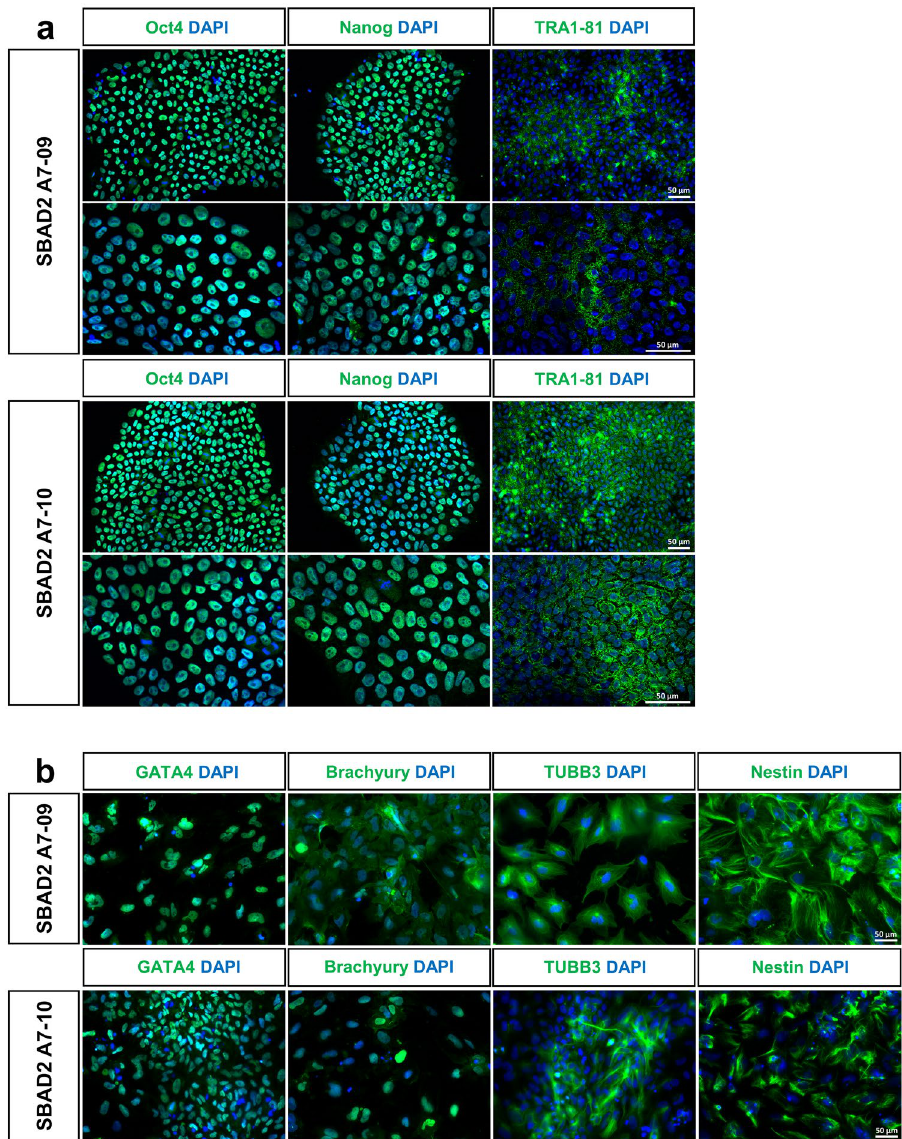
Figure 5. Pluripotency tests. ( a ) Representative immunofluorescent micrographs of undifferentiated SBAD2- iRFP720 reporter hiPSCs, that were positively stained for stem cell markers OCT4, NANOG and TRA1- 81 (in green), nuclei were labeled with DAPI (in blue). ( b ) SBAD2-iRFP720 hiPSCs were spontaneously differentiated and analyzed by immunocytochemistry. Multilineage differentiation potential was confirmed by immunostaining for endodermal (GATA4), mesodermal (BRACHYURY) and ectodermal (TUBB3, NESTIN) germ layers (in green), nuclei were labeled with DAPI (in blue). Scale bar: 50